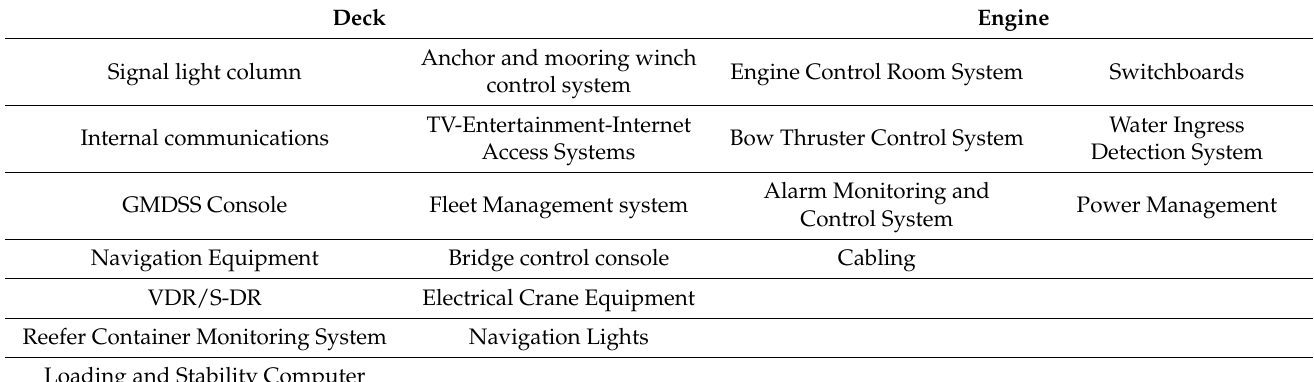
Table 2. Ship ecosystem